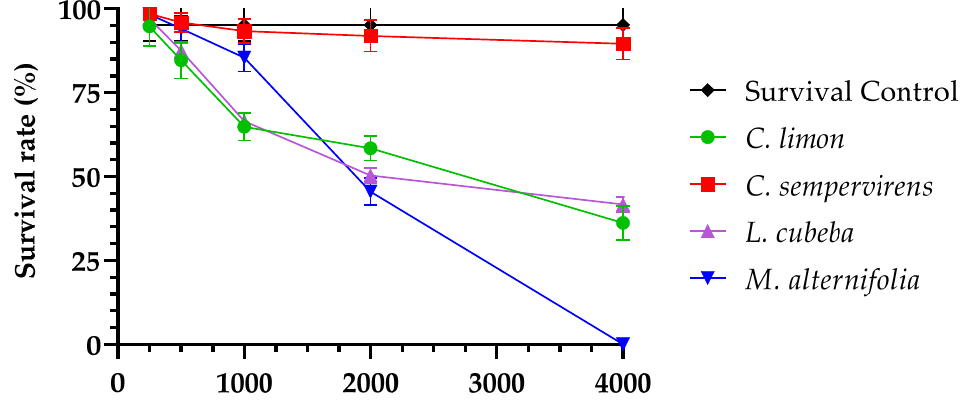
Figure 1. Survival rate (%) of C. elegans larvae in 24 h, evaluated at different concentrations of essential oils of C. limon , C. sempervirens , L. cubeba and M. alternifolia . Table 5. Mean survival rate (%) of C. elegans tested at different concentrations of essential oils from C. limon , C. sempervirens , L. cubeba and M. alternifolia . Concentration (µg/mL)